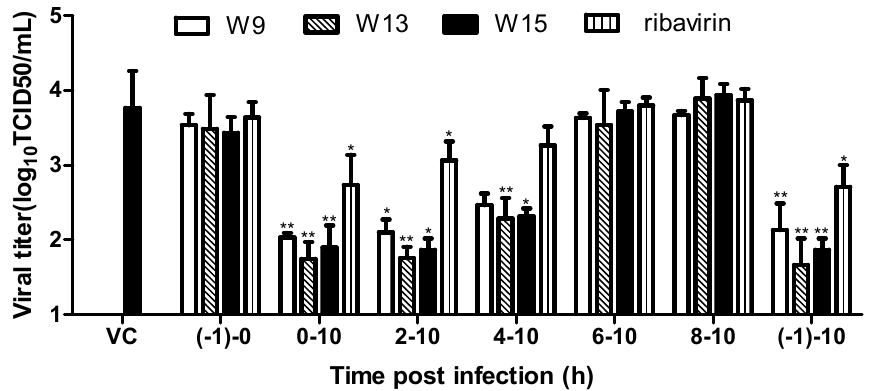
Figure 4. Time-of-addition assay. 120 μ M W-9, or 160 μ M W-13, W-15, or ribavirin, were added to Hep-2 cells for different time periods after CVB3 infection. Progeny virus yield was determined at 12 h post-infection (( − 1)–0 h, viral infection period; 0–10 h, period of virus proliferation in cells). Values are presented as means ± SDs. * p < 0.05; ** p < 0.01, compared with the virus control group.